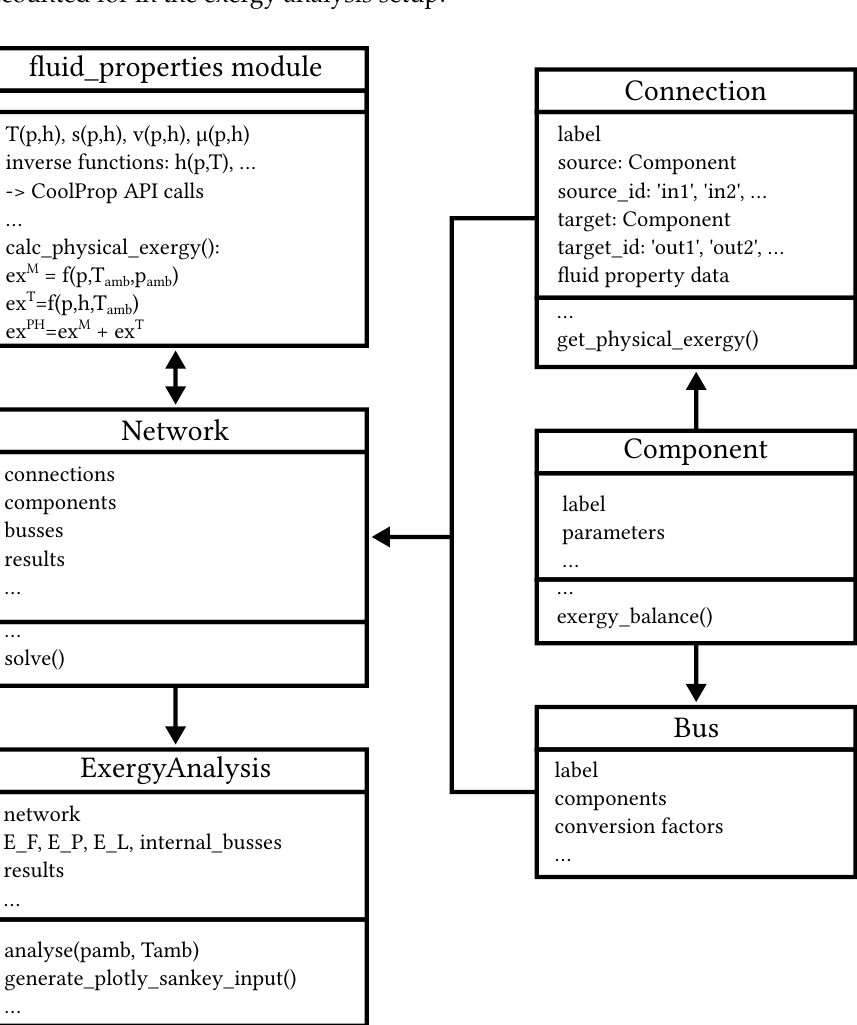
Figure 3. Simplified structure of the TESPy package and the embedding of the exergy